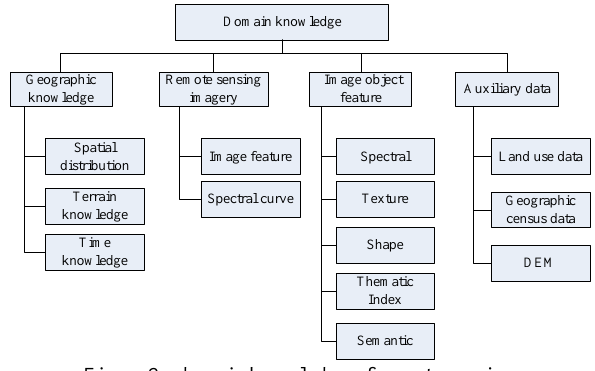
Figure 2. domain knowledge of remote sensing